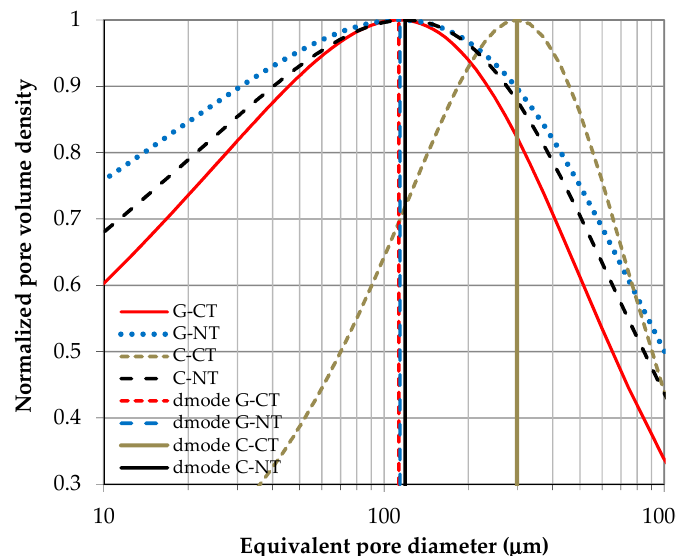
Figure 8. Normalized pore volume distributions and the corresponding modal diameters (d mod ) of the four site–soil management combinations (G, Gravina; C, Candela; CT, conventional tillage; NT, no-tillage), calculated according to Reynolds et al. [62].